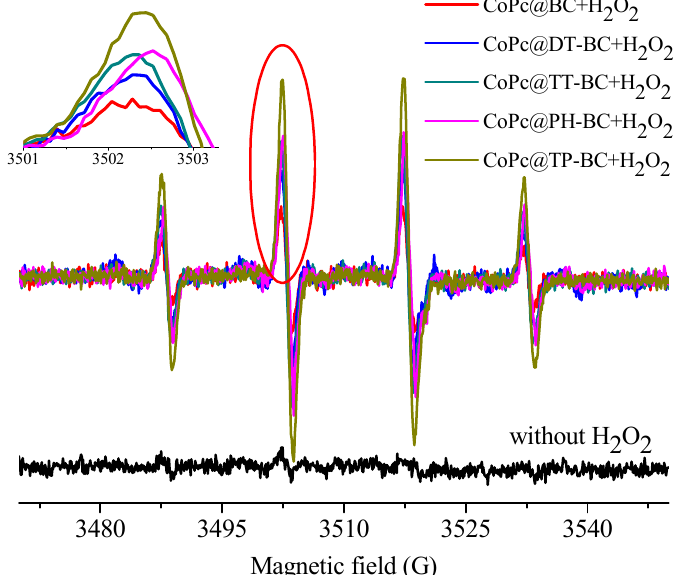
Figure 9. 5,5-dimethyl-1-pyrroline-N-oxide (DMPO) spin-trapping electron paramagnetic resonance (EPR) spectra of reactive red X-3B dye wastewater (initial concentration 100 μ M, pH = 2, T = 50 °C). The inset shows the magnification of the marked region.